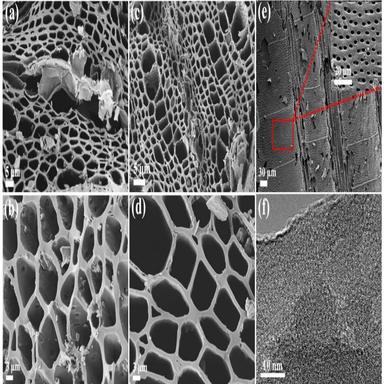
(a,b) Top viewed SEM image of raw carbon material (PMCC), (c,d) Top viewed SEM image of PMCHC, (e) Cross-sectional viewed SEM images of PMCHC and its partial enlargement (inset), (f) TEM for the PMCHC.